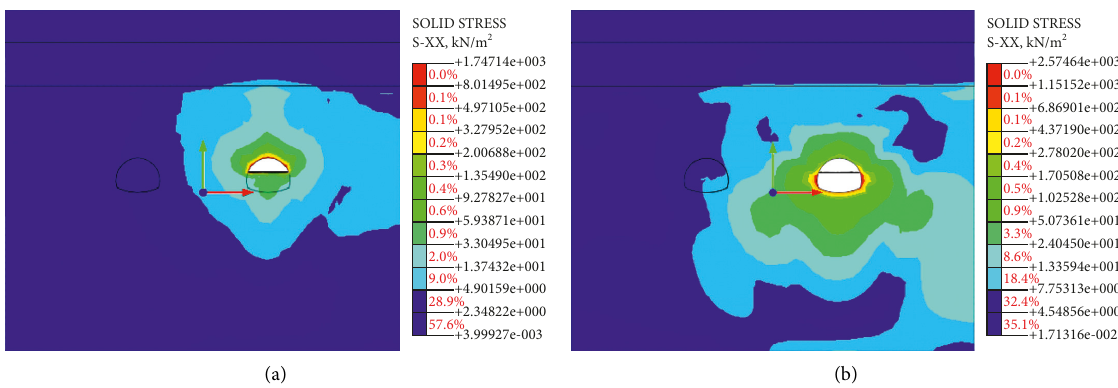
Figure 24: Stress distribution of surrounding rock (tunnel clear distance 2D). (a) Excavation of upper step and (b) excavation of lower